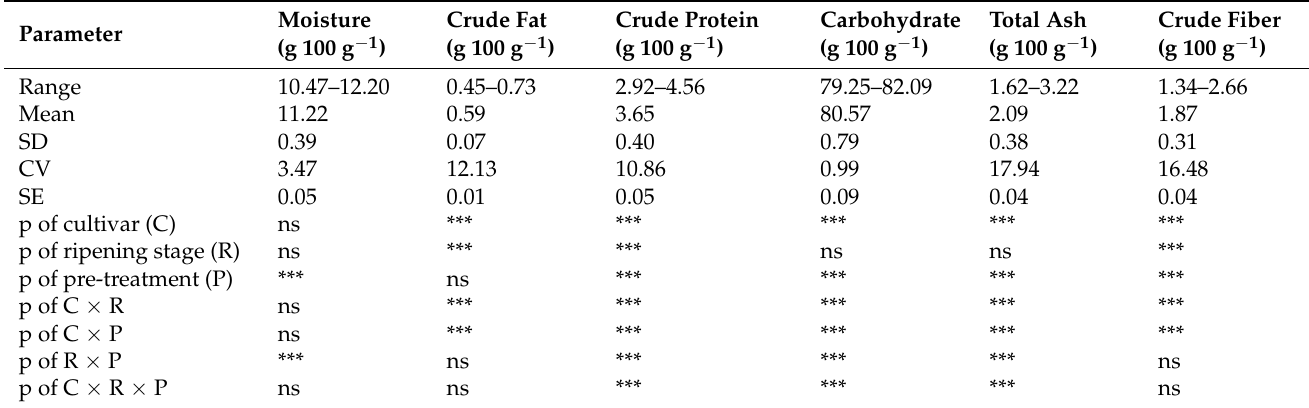
values in the False Horn Mbouroukou 3 while the level of crude fiber was lower by 27.5% (Table S1). With the same French type of bunch, Mbouroukou 3, had higher crude protein content and total ash than the plantain hybrids PITA 27 and PITA 14, whereas PITA 27 was better in crude fiber content. Table 1. ANOVA statistics showing the effect of cultivar, ripening stages, and pre-treatment methods on the proximate composition of plantain